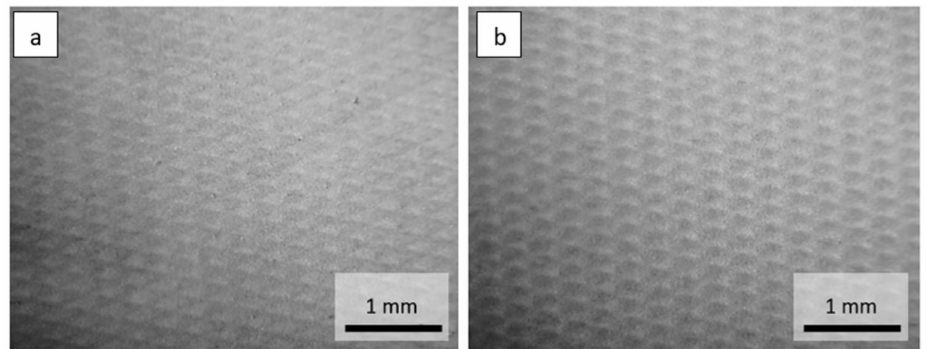
Figure 3. Optical microscope images of the materials: ( a ) Vapor-permeable PE foil 15 g · m − 2 , ( b ) Vapor- permeable PE foil 25 g · m − 2 .